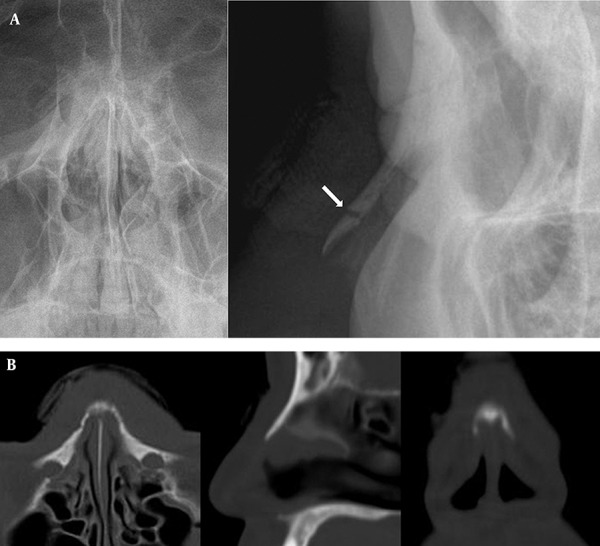
A 36-year-old man with painful nasal swelling and a simple non-depressed transverse nasal fracture. A, Coronal and lateral conventional radiography images show a discrete simple fracture in the mid-portion of the nasal bone. B, CT images show no discrete fracture on axial, sagittal, and coronal reformatted images (arrow indicates nasal bone fracture).